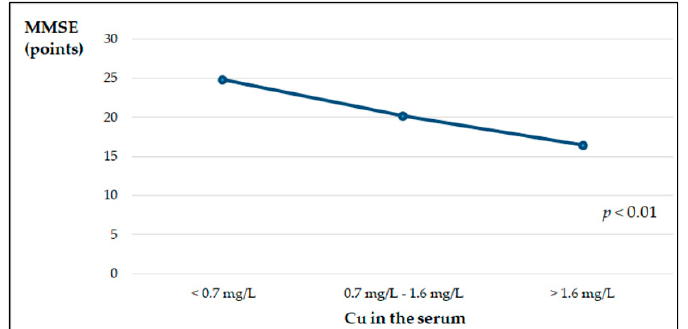
Figure 1. MMSE point scale depending on copper concentration in the serum of patients with AD, estimated by the ANOVA Kruskal–Wallis test.